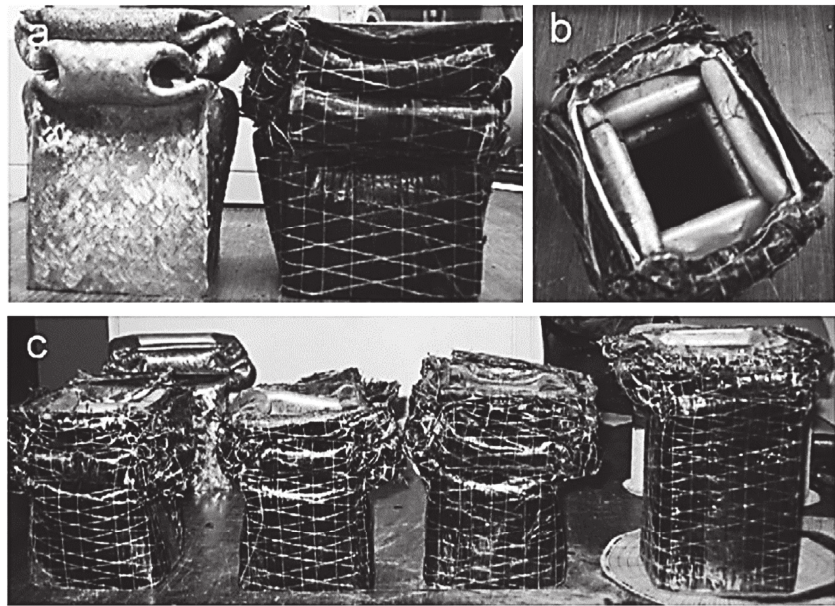
Figure 1: Laboratory sample of Bombach et al.